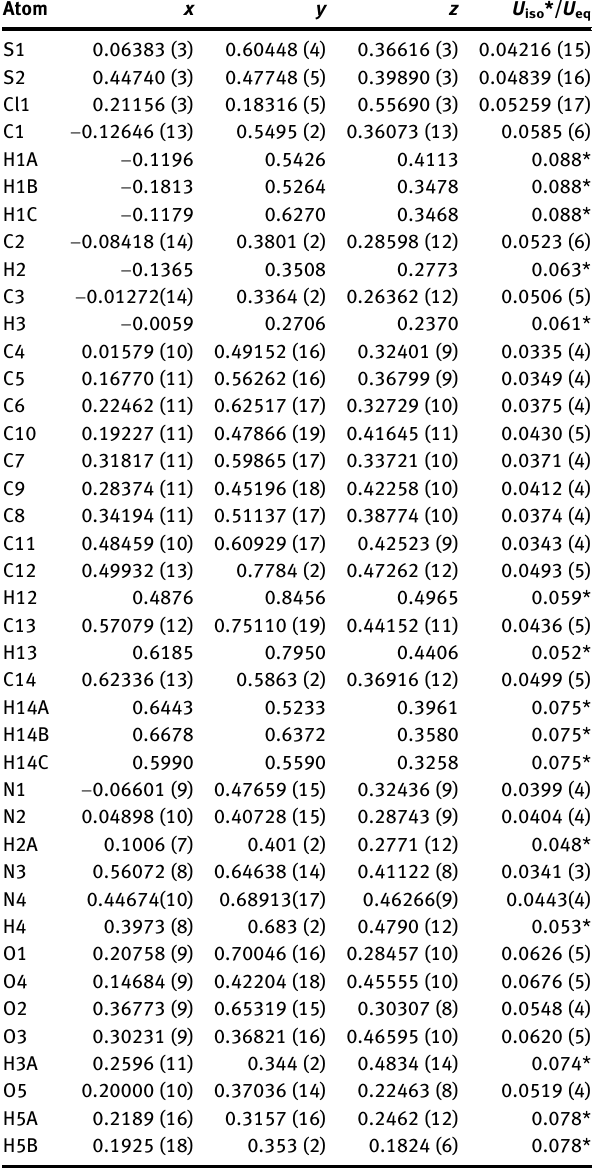
Table  : Fractional atomic coordinates and isotropic or equivalent isotropic displacement parameters (Å 